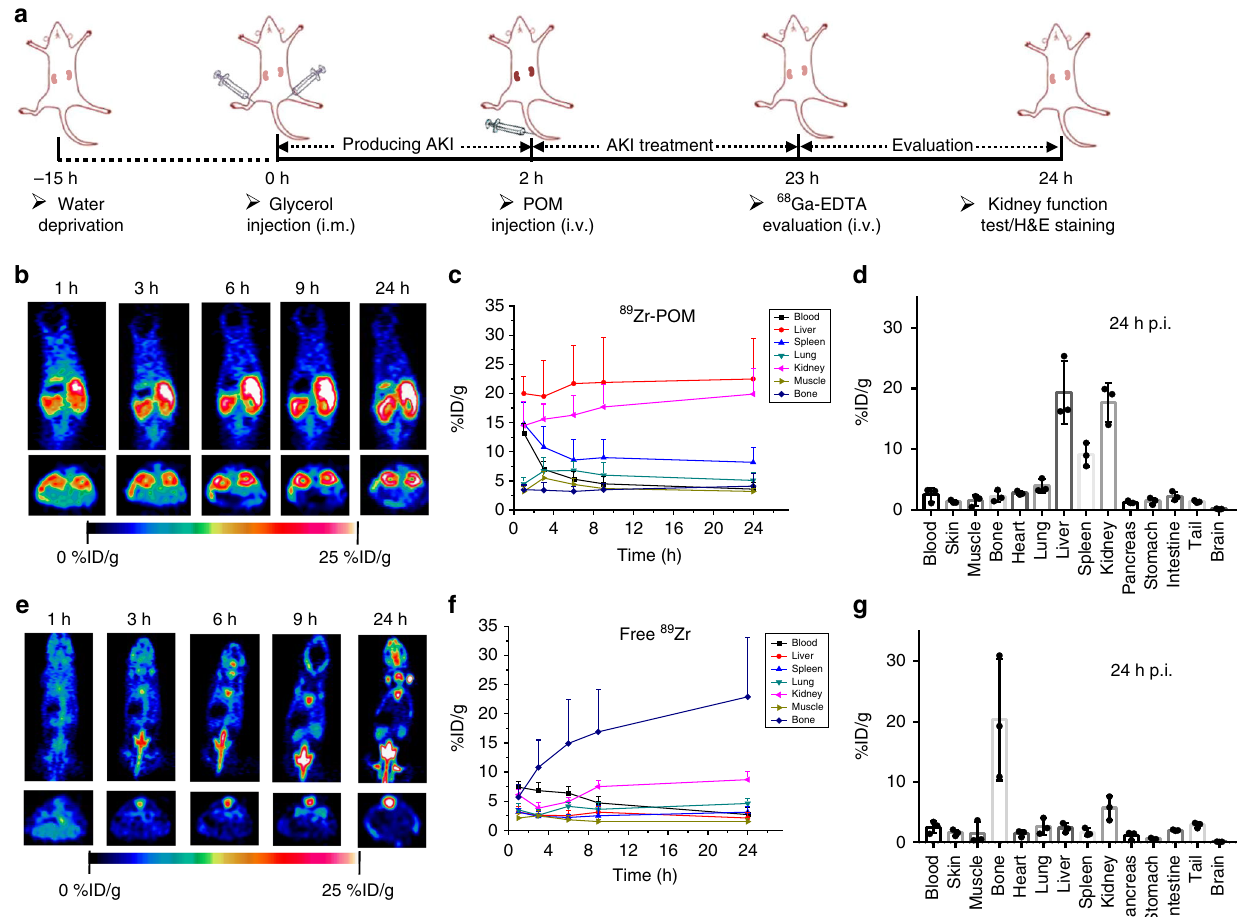
Fig. 3 Schematic of AKI treatment and biodistribution of POM nanoclusters in AKI mice. a Preparation and treatment schedule of AKI mice. Representative longitudinal PET imaging of 89 Zr-POM ( b ) and free 89 Zr ( e ) in mice with AKI. (top: coronal slices; down: axial slices). Quanti fi cation of 89 Zr-POM ( c ) and free 89 Zr ( f ) uptake in the blood, liver, spleen, kidneys, and muscle at various time points p.i. Biodistribution of 89 Zr-POM ( d ) and free 89 Zr ( g ) at 24 h p.i. in AKI mice as determined by 89 Zr radioactivity measurement in various tissues and organs. In c , d and f , g , data represent means ± s.d. from three independent